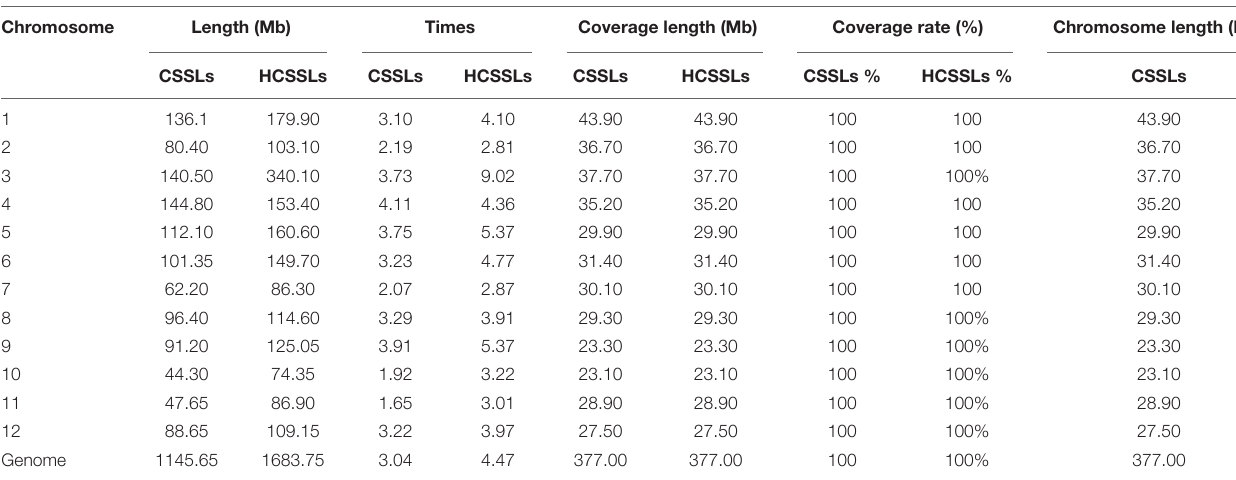
FIGURE 6 | Distribution of the length of the substituted chromosome segments in the 244 HCSSLs based on the physical map constructed with molecular markers. TABLE 3 | Chromosome coverage of substituted segments in CSSLs and